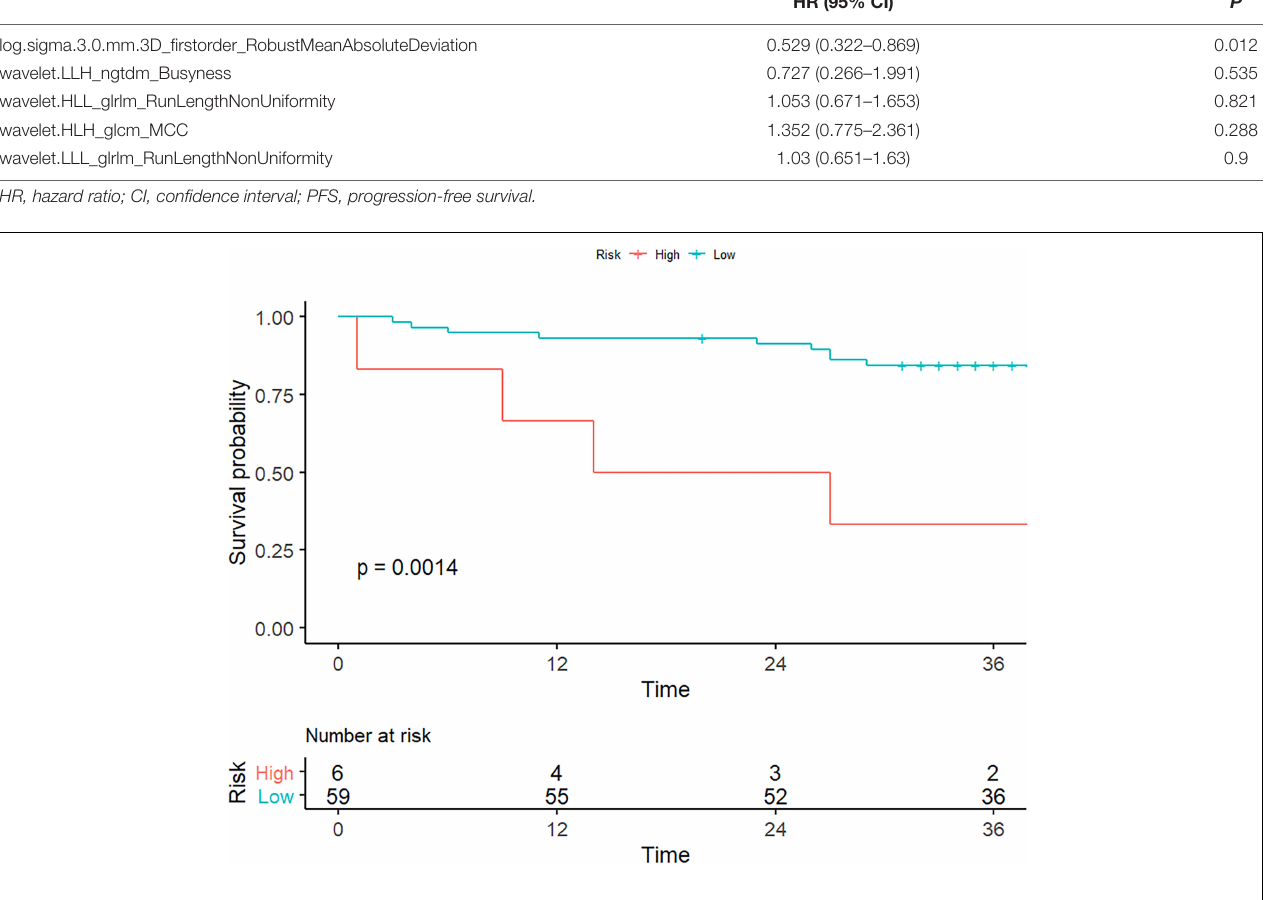
FIGURE 4 | Texture features for the evaluation of patient survival. As the picture depicts, only the liver-derived feature of log.sigma.3.0.mm. 3D_firstorder_RobustMeanAbsoluteDeviation could stratify patients with portal hypertension into high- or low-risk group (log-rank test, p <